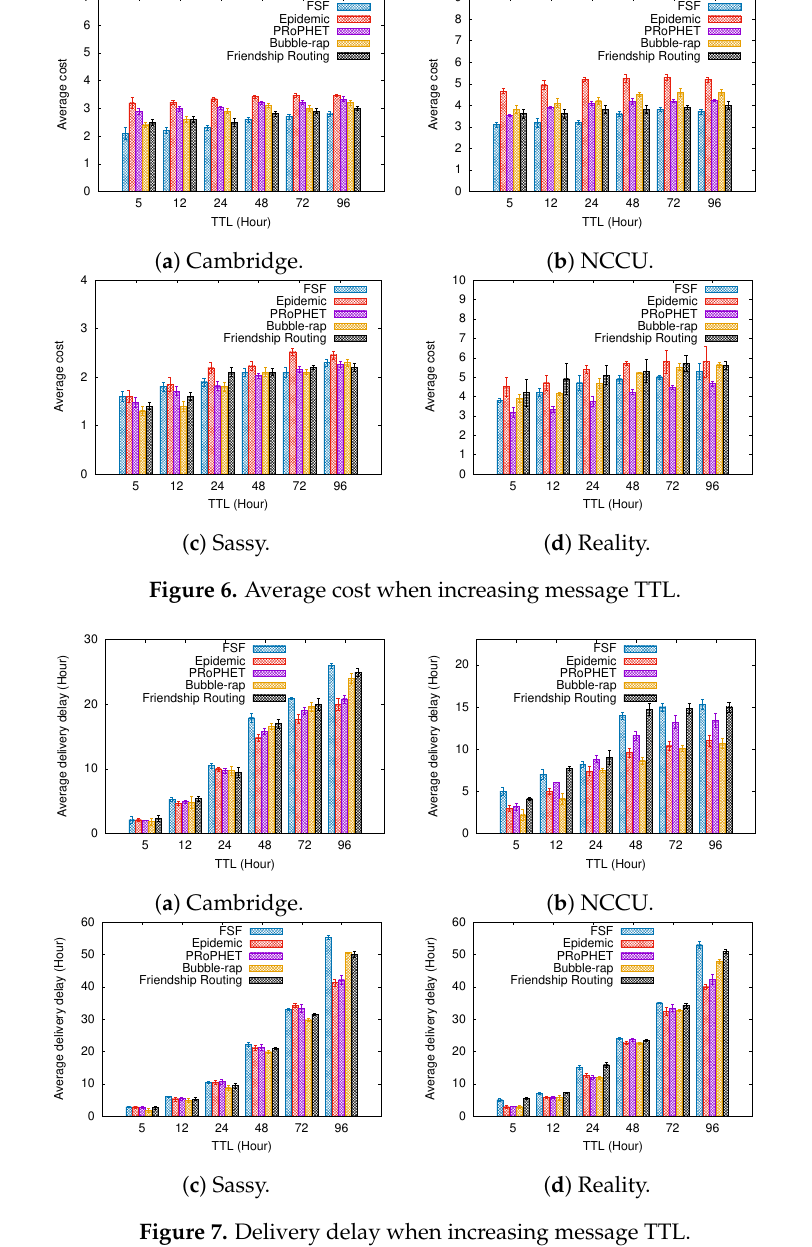
Figure 7. Delivery delay when increasing message